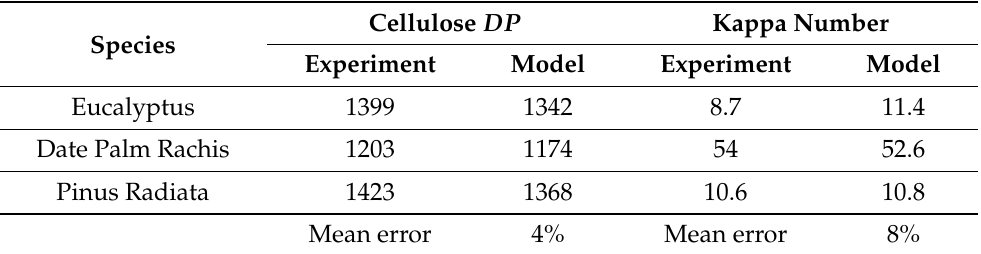
Table 2. A comparison of the cellulose DP and Kappa number between the experimental data and model simulation at the end of the pulping process ( t = t end ) for three different wood species [61–63].